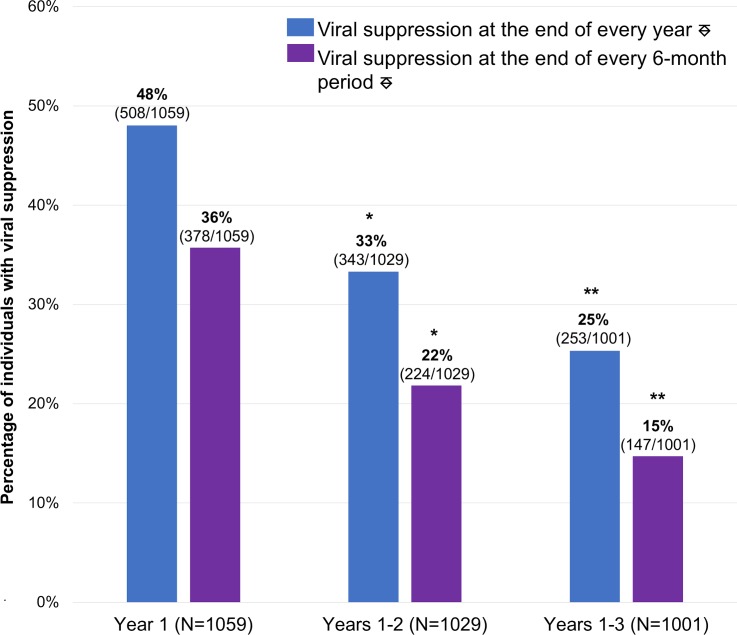
Longitudinal HIV viral suppression (VS) at 1, 2, and 3 years post-release.⎑Individuals with detectable viral loads during these time frames were considered virally suppressed if their last viral load within the time frame of interest was <400 copies/ml. *Statistically significant decline in VS compared with initial 1-year rates (McNemar’s test p < 0.001). **Statistically significant decline in VS compared with sustained 2-year rates (McNemar’s test p < 0.001).